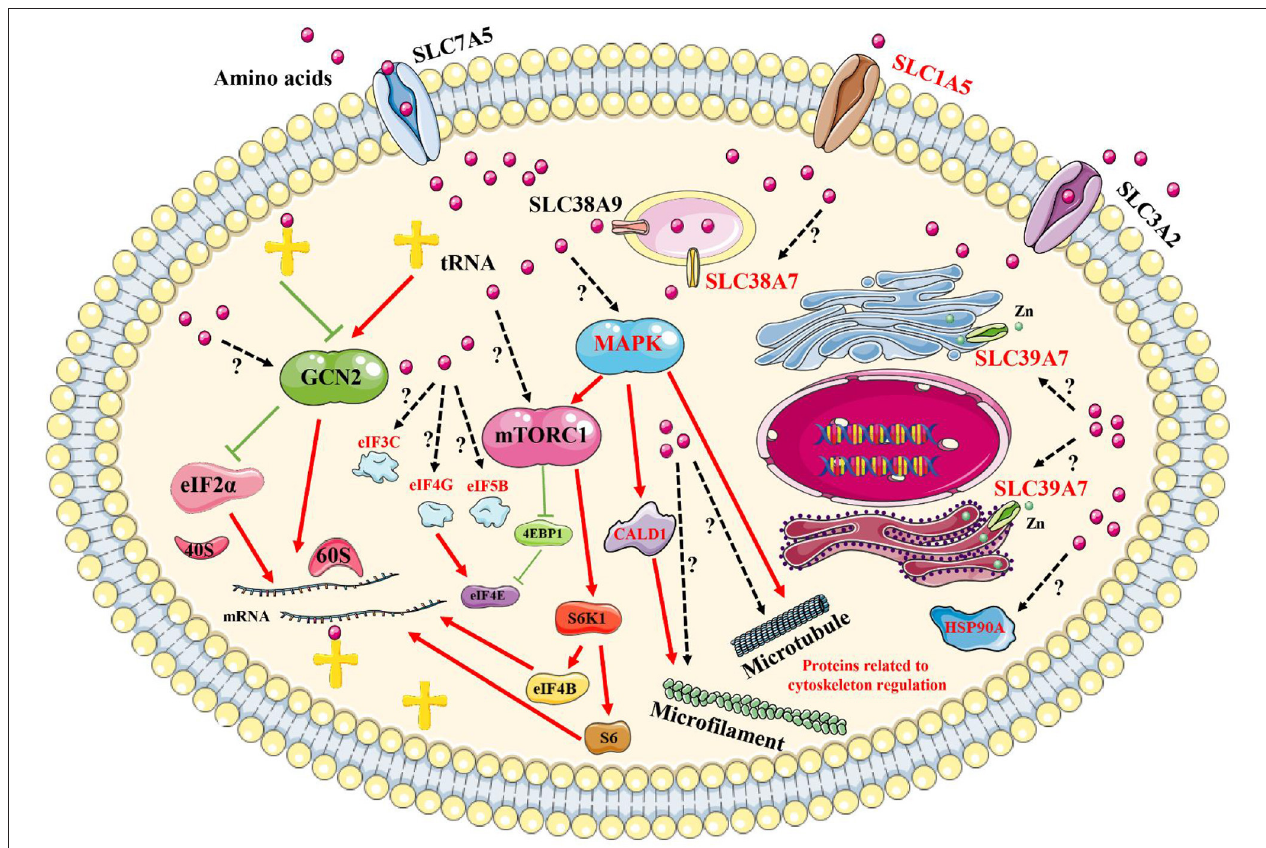
FIGURE 8 | Brief model diagram showing the signaling pathways induced by amino acid signals. Amino acids may be sensed and transported by transporters on the plasma membrane and endomembrane system. Then, the signals are transmitted to the GCN2, mTORC1, and MAPK signaling pathways, which control various physiological and biochemical processes via the regulation of downstream effectors. Red marked proteins were identified in this study, with red lines representing activation, whereas green lines represent inhibition. Dotted lines and question marks represent related functions with unspecified